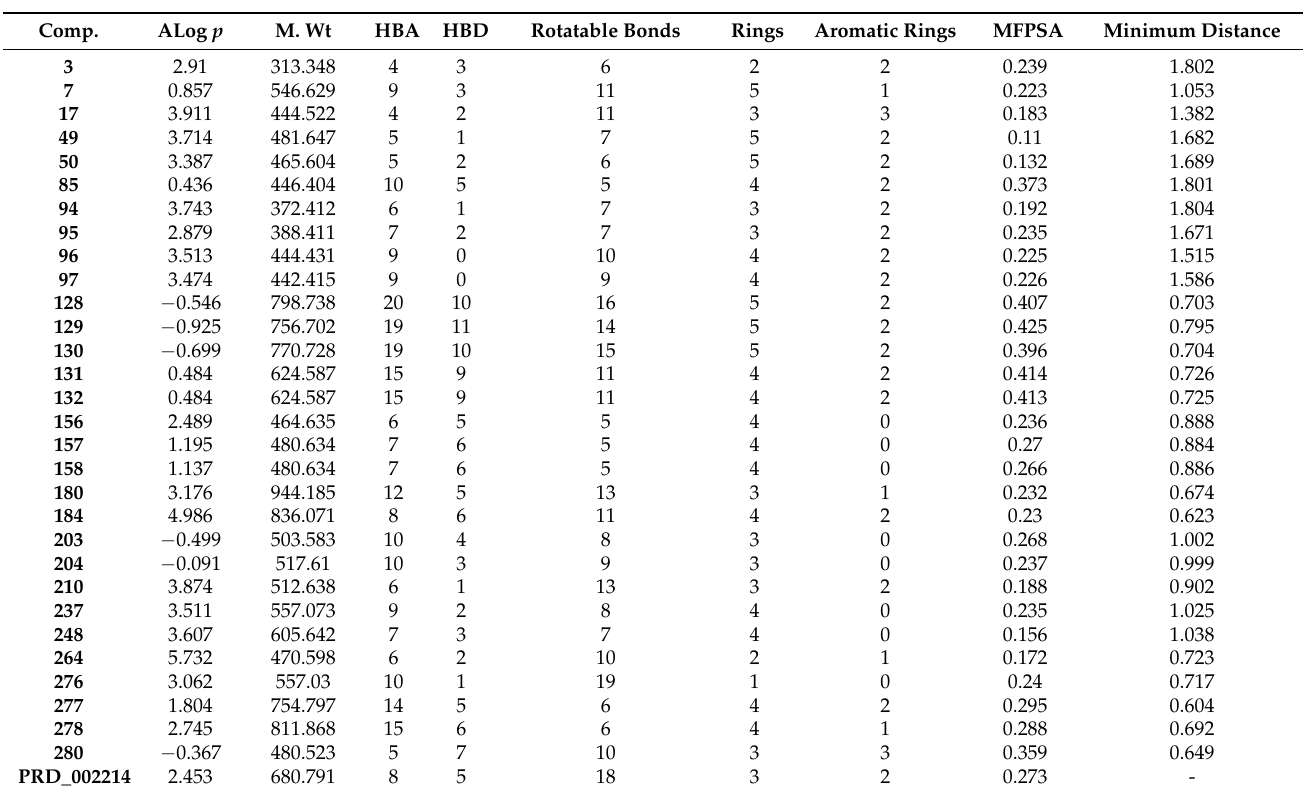
Table 1. The calculated molecular properties of compounds having structural similarity with PRD_002214 .